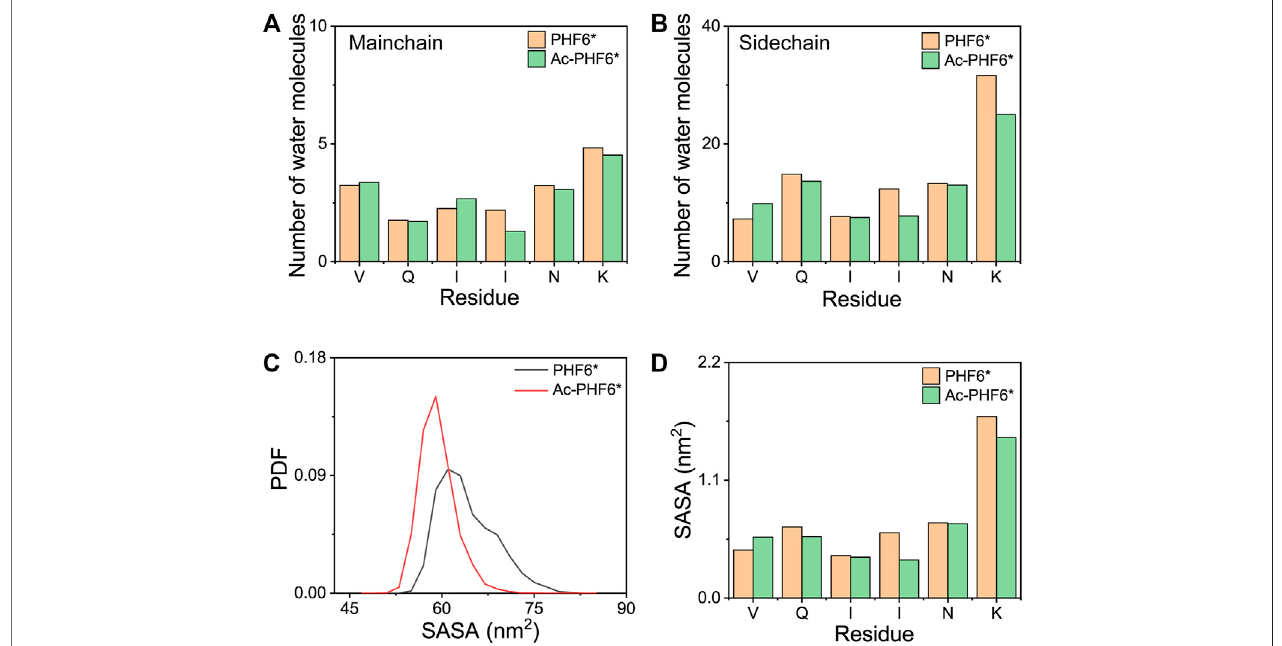
FIGURE4| Theaveragenumberofwatermoleculeswithin0.35 nmofthemainchain (A) andsidechain (B) atomsofeachresidueinPHF6*andAc-PHF6*systems. Probability distribution function of the solvent accessible surface area (SASA) for all residues (C) and SASA as a function of each residue (D) .